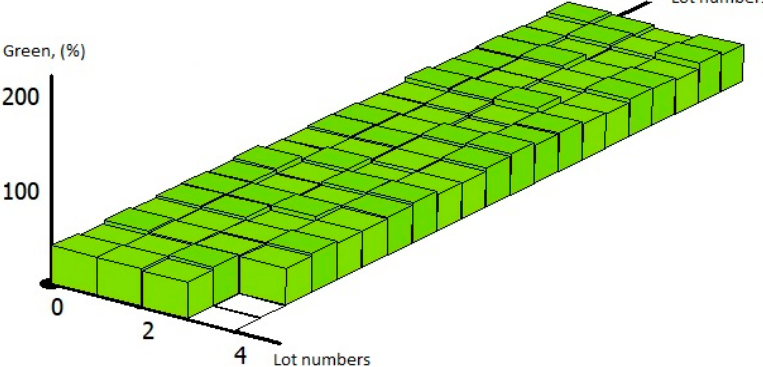
Figure 8. Distribution of the reflection parameters over elementary areas of the field with sowing of spring wheat in the “green” region of the spectrum.